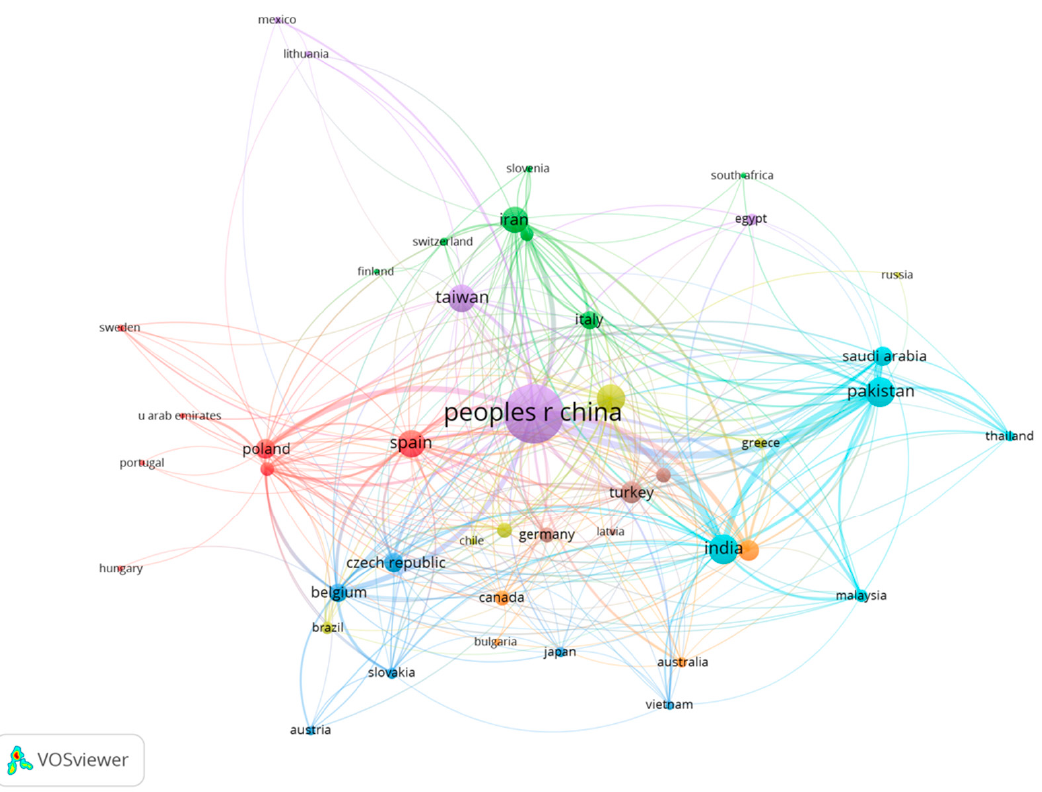
Figure 7. Bibliographic coupling for countries. Network visualization.